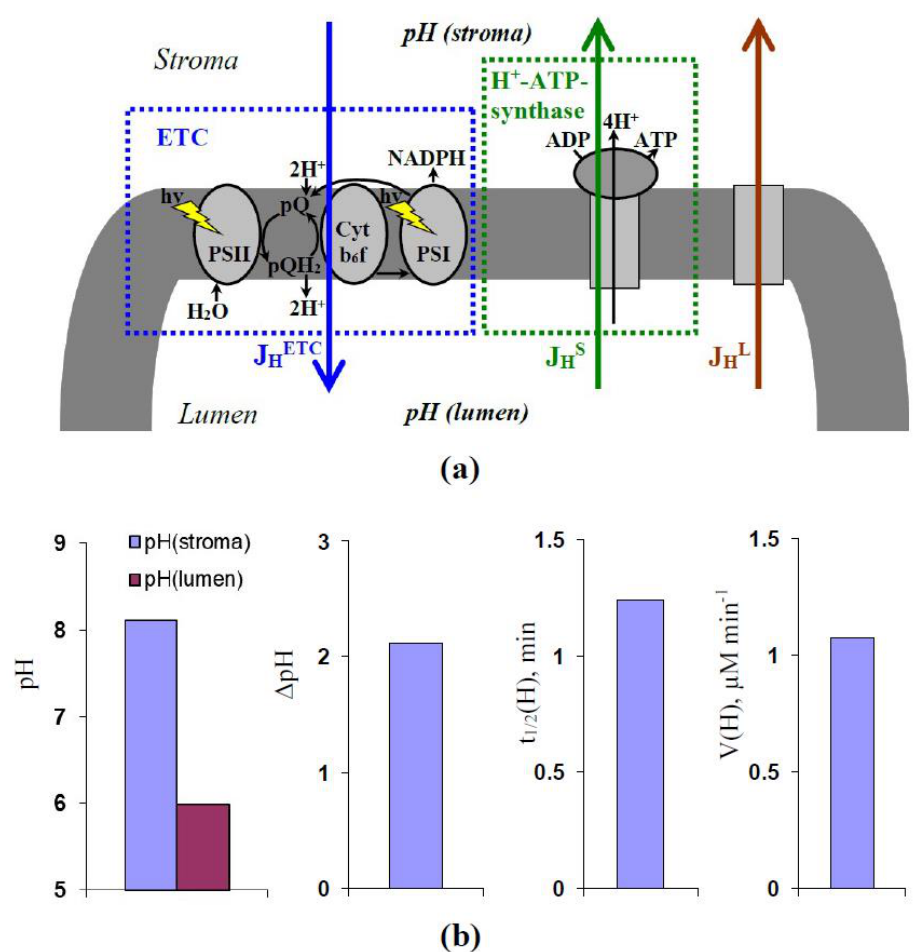
Figure 5. ( a ) Scheme of main H + fluxes described in the model. J HETC is the H + flux per volume caused by the chloroplast electron transport chain (ETC) (Equation (3)). J HS is the H + flux per volume caused by the H + -ATP synthase (Equation (4)). J HL is the additional integral H + flux per volume, which can be caused by proton leakage and/or activity of H + transporters in the thylakoid membrane including the H + /Ca 2+ antiporter, H + /K + antiporter, and the proton/phosphate transporters (Equation (5)). PSI and PSII are the photosystems I and II, respectively. Cyt b 6 f is the cytochrome b 6 f complex. pQ and pQH 2 are the pools of plastoquinone and plastoquinol, respectively; ( b ) parameters of changes in H + concentrations simulated by the model. pH(stroma) and pH(lumen) are the stationary stromal and luminal pH in chloroplasts (Equations (2) and (7)). ∆ pH is the pH gradient equaling to the difference between pH(stroma) and pH(lumen). t 1/2 (H) is the time taken for a 50% increase in H + concentration in the lumen of chloroplasts (Equation (8)). V(H) is the absolute velocity of change in H + concentration in the lumen at the initiation of illumination ((Equation (9)). The analysis was carried out at k ETC = 0.05 s − 1 (the velocity constant of H + transport through ETC), k S = 0.13 s − 1 (the velocity constant of H + transport through the H + -ATP synthase), and k L = 0 s − 1 (the velocity constant of the additional H +